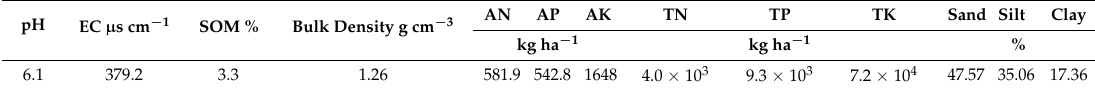
Table 1. Chemical properties of the studied soil.